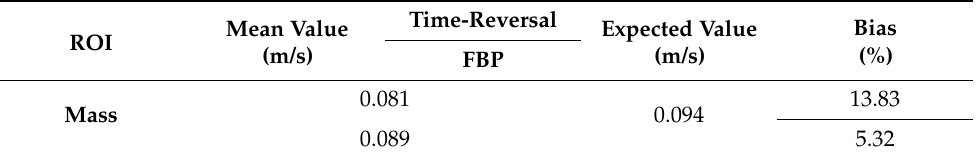
Table 5. Mean value, expected value, and bias of the mass shown in Figure 12 for attenuation coefficient